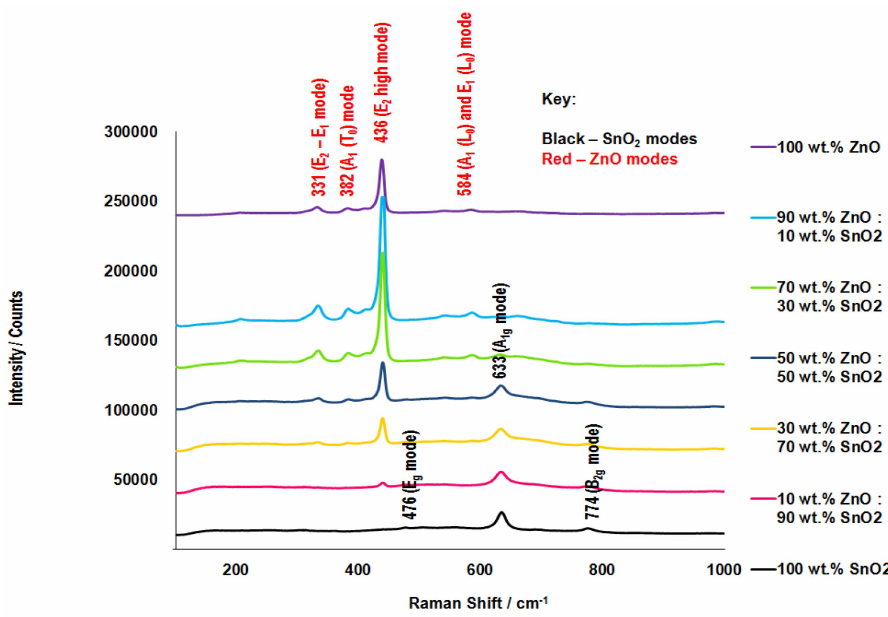
Figure 3. Raman spectra of all sensor devices within the SnO 2 -ZnO sensor array. All sensors were heat-treated at 600 ˝ C, prior to Raman spectroscopy